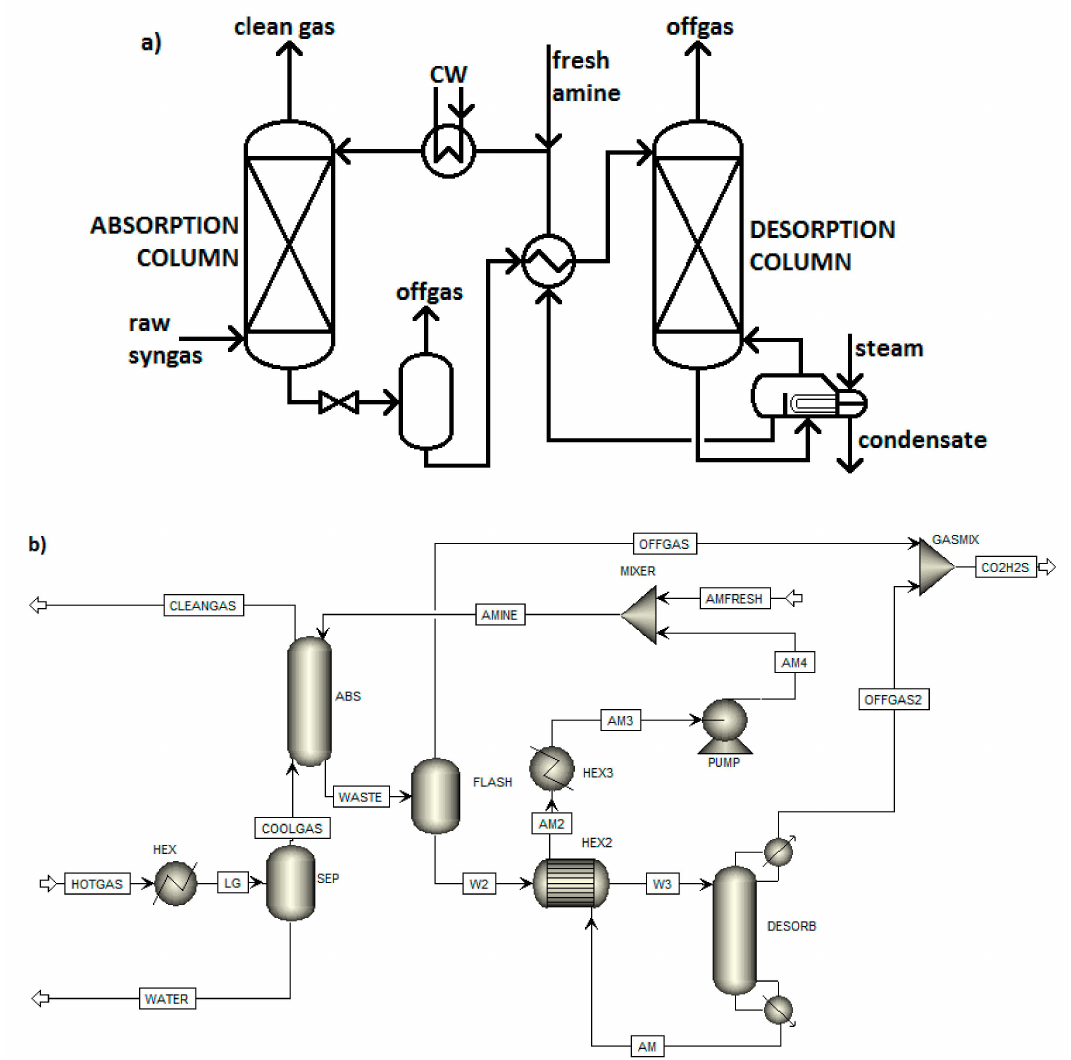
Figure 5. Scheme of syngas cleaning and MDEA regeneration ( a ) and the corresponding Aspen Plus scheme ( b